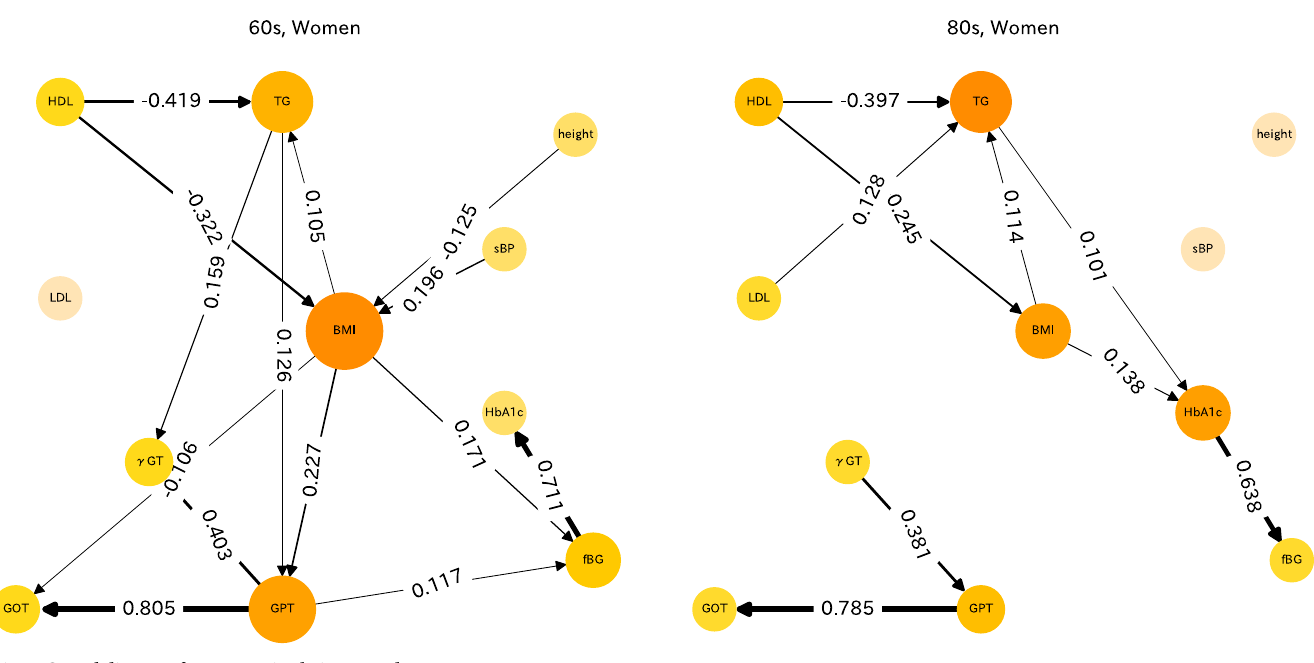
Fig 5. Causal diagram for women in their 60s and